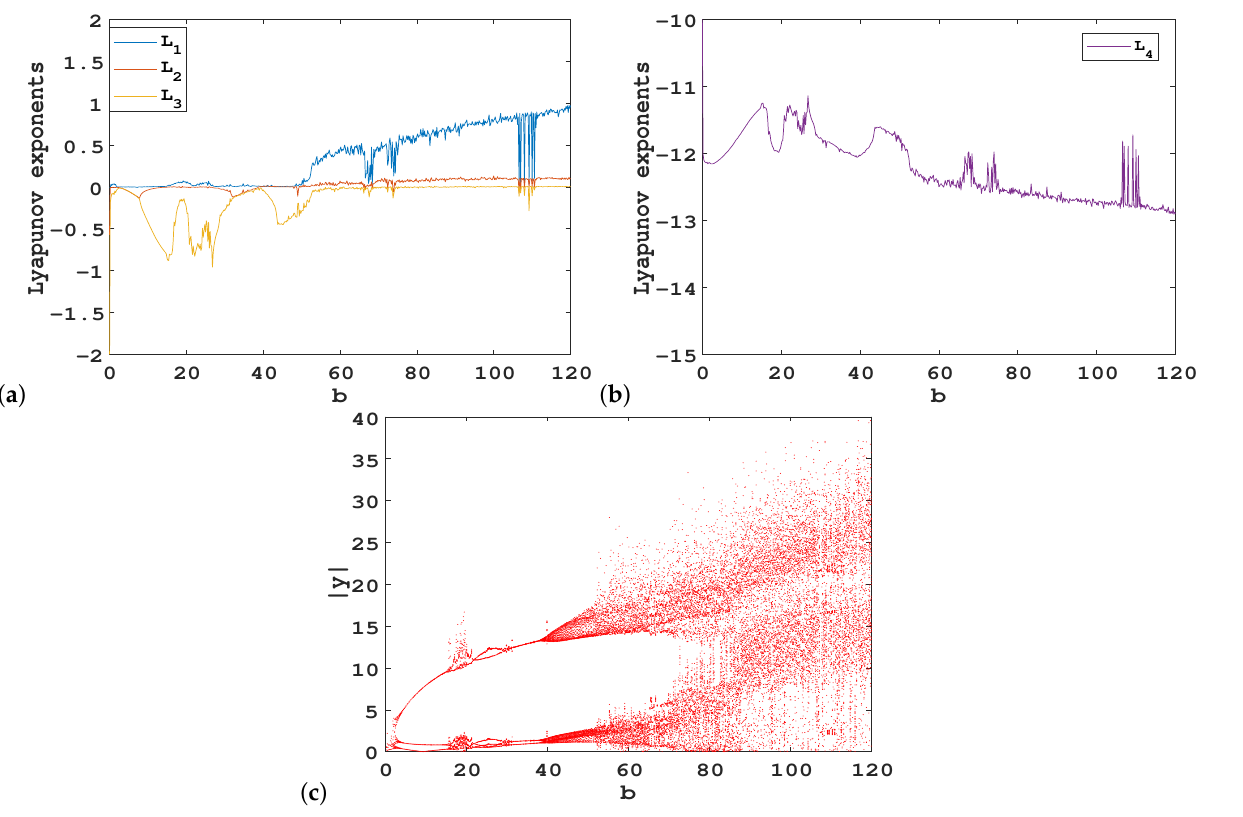
Figure 5. Dynamics of system (2) versus parameter b ∈ [ 0,120 ] with ( a , c , k , m ) = ( 10,2.7, − 0.2,1 ) : ( a , b ) Lyapunov exponent spectrum; ( c ) bifurcation diagram.